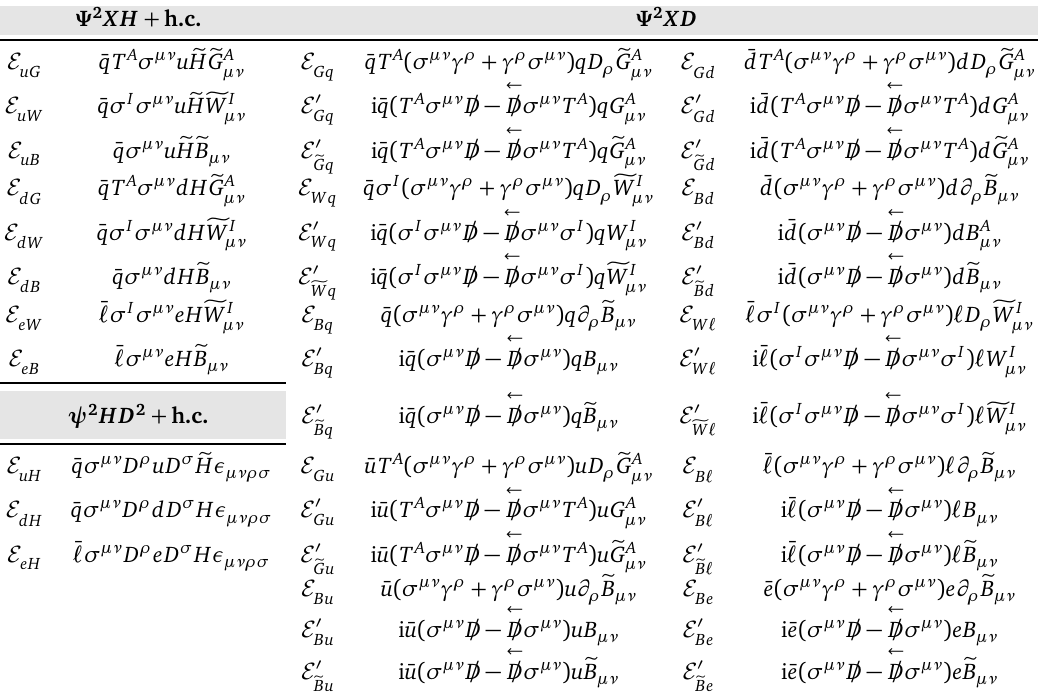
Table 4: Evanescent operators with two